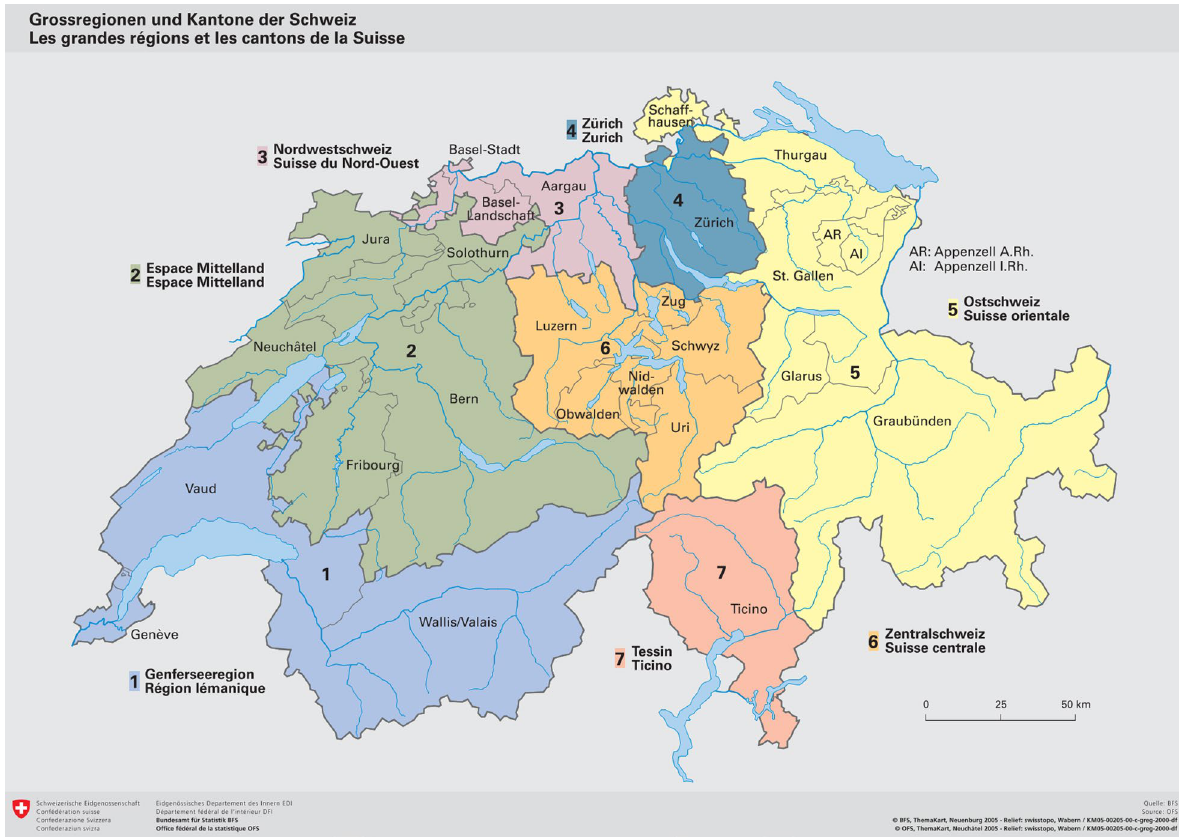
Fig. 10 Cantons and major regions in Switzerland. Source: Federal Statistical Office